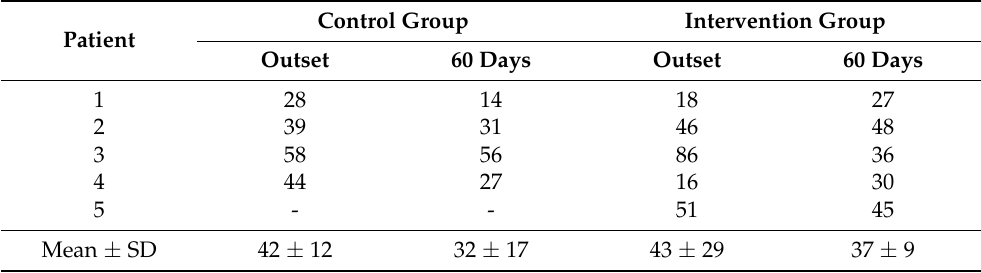
Table 5. Effect on skin hydration of treatment with cold creams CBlank (Control) and CPropolis (Intervention) for 60